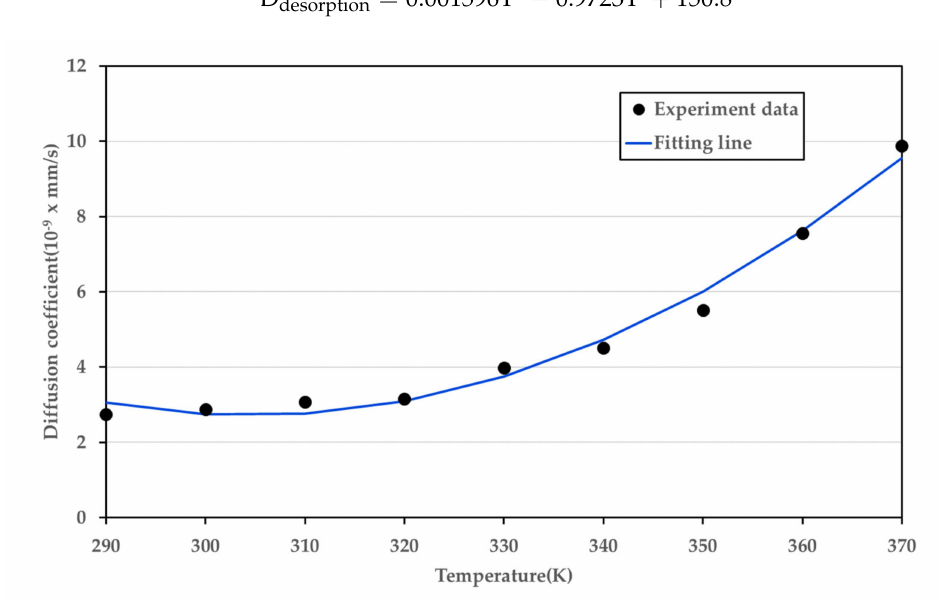
Figure 9. Diffusion coefficient of the sorption process at various temperatures and pressures.